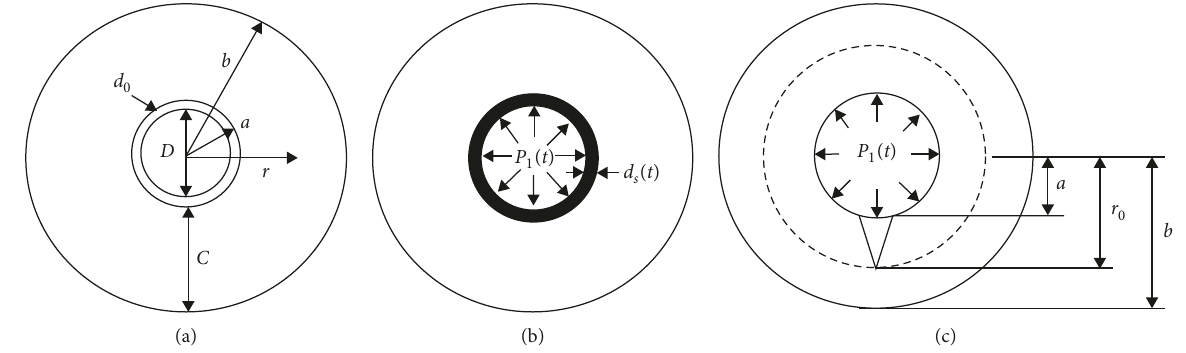
Figure 1: Schematic of crack evolution: (a) reinforced concrete considered to be a thick wall cylinder; (b) expansion stress caused by corrosion products; (c) concrete cover cracking.